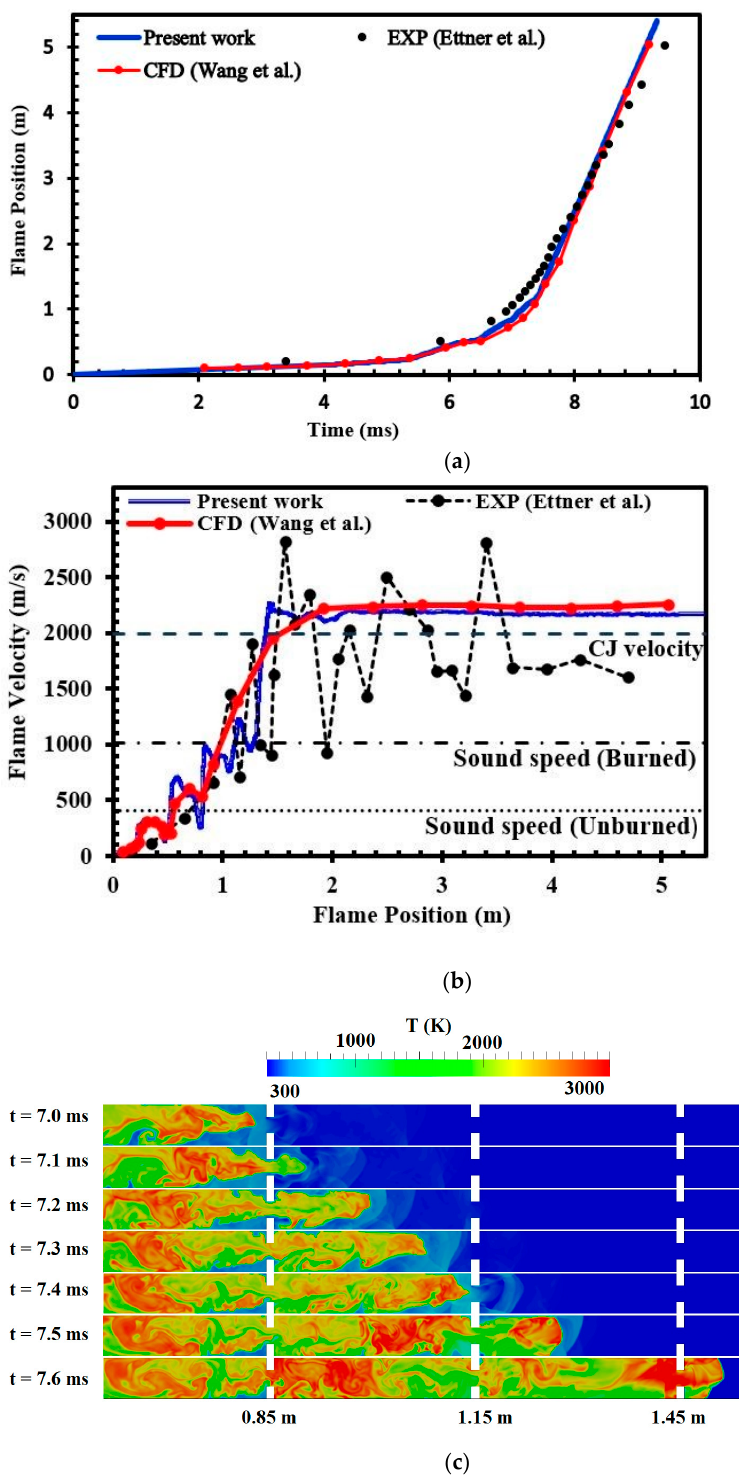
Figure 7. ( a ) The flame-tip position at different times in the inhomogeneous H 2 –air mixture with 30% hydrogen concentration, along with the experimental results of Ettner et al. [43] and the numerical results of Wang et al. [66]. ( b ) The flame velocity in the inhomogeneous H 2 –air mixture with 30% hydrogen concentration, along with the experimental results of Ettner et al. [43] and the numerical results of Wang et al. [66]. ( c ) The predicted contours of temperature during FA and DDT in the inhomogeneous H 2 –air mixture with 30% hydrogen